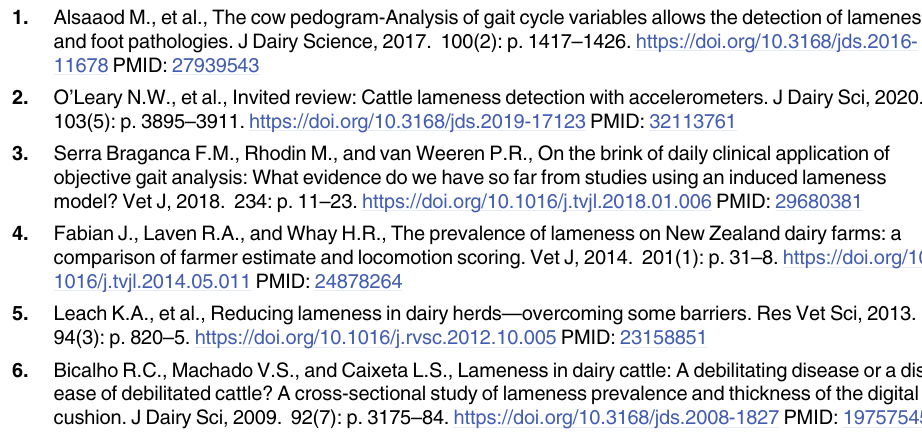
S1 Table. Cow characteristics. (SR stands for the Swedish Red-and SH stands for the Swedish Holstein